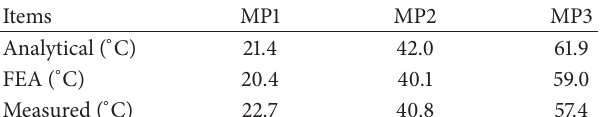
Table 3: The analytical, FEA, and measured winding temperature rise of MP1, MP2, and MP3.